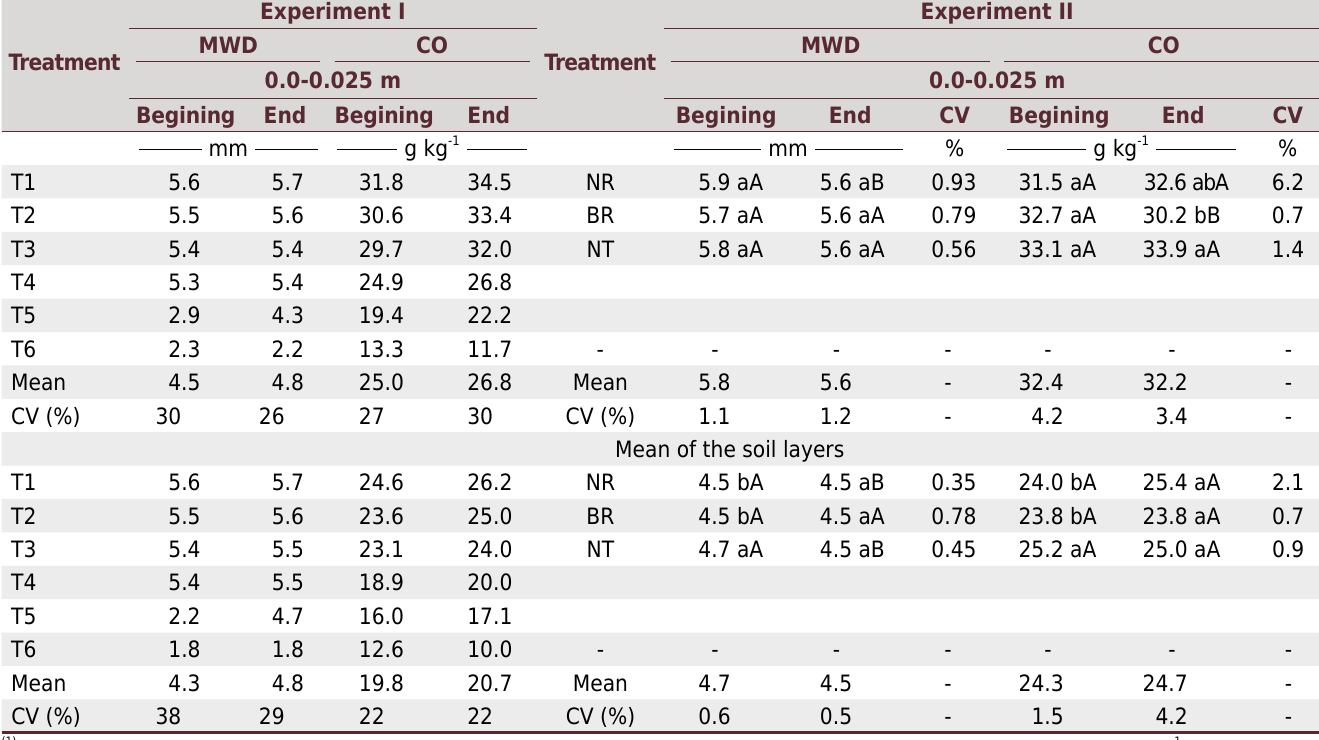
Table 2. Mean weighted diameter of aggregates (MWD) and organic carbon concentration (CO) in the soil at the beginning and at the end of the study, determined in the treatments (Treat) of experiments I and II in the 0.0-0.025 m layer and in the mean of the 0.0-0.025, 0.025-0.05, 0.05-0.10, and 0.10-0.20 m layers